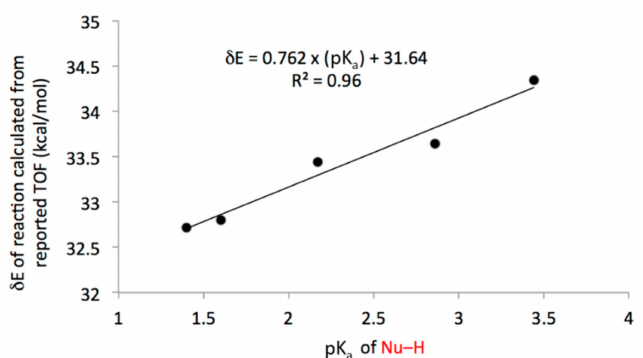
Figure 4. Apparent energetic span of the esterification of 2-octanol facilitated by 1a as a function of the pK a of the pronucleophile (from left to right: 2,4-dinitrobenzoic acid, pentafluorobenzoic acid, 2-nitrobenzoic acid, 2-iodobenzoic acid, 4-nitrobenzoic